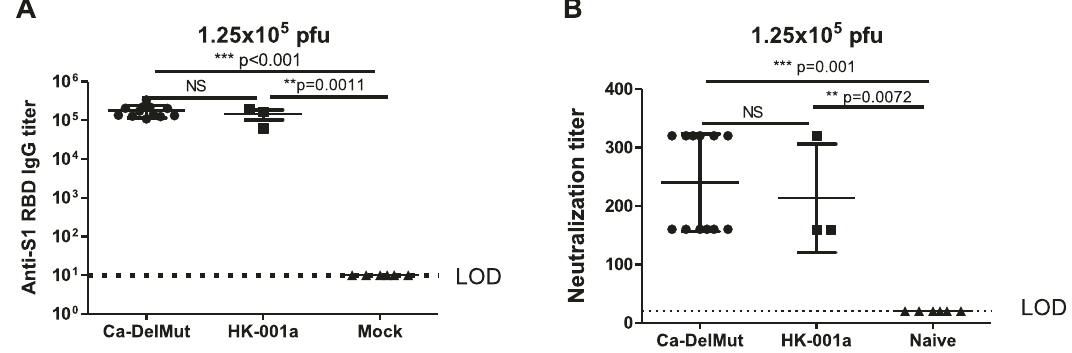
Fig. 4 Antibodies induced by Ca-DelMut immunization of hamsters. Hamsters were immunized intranasally with 1.25 × 10 5 pfu of either Ca-DelMut ( n = 12) or wild-type virus (HK-001a) ( n = 3) 18,25 , or mock immunized ( n = 6). At day 21, blood was collected from hamsters and tested for ( A ) anti-S1 RBD-speci fi c IgG titers and ( B ) neutralization activity against the HK-13 virus strain. Error bars represent mean ± SD. LOD: level of detection. Statistical comparisons between means were performed by Student ’ s t -test (2-tailed): * p < 0.05, NS: not signi fi